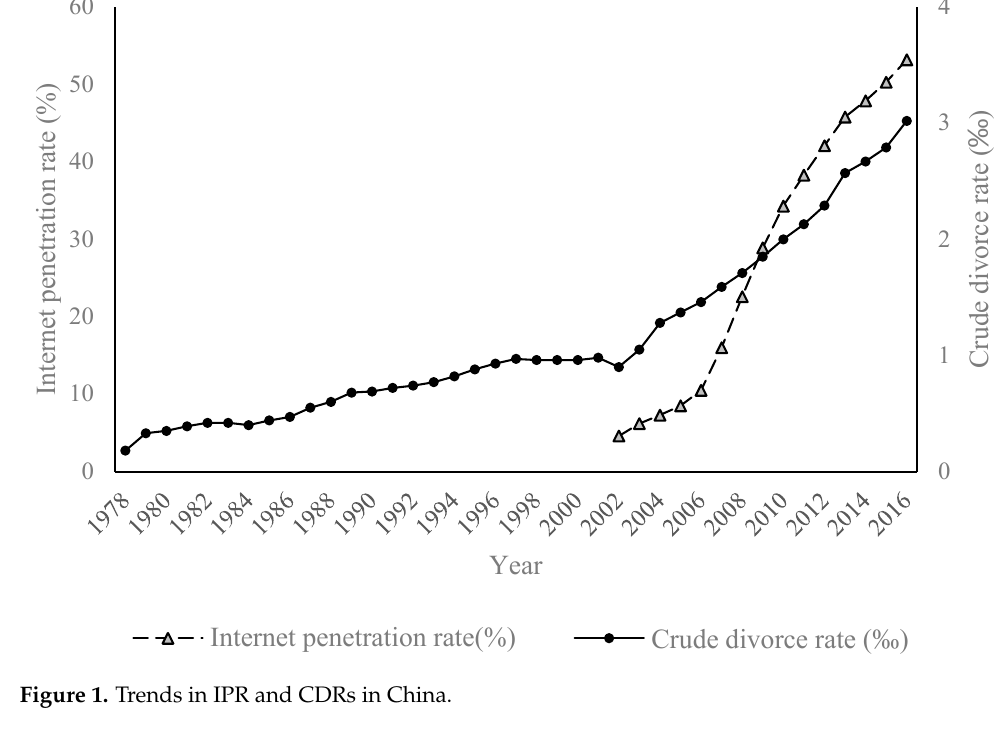
Figure 1. Trends in IPR and CDRs in China.